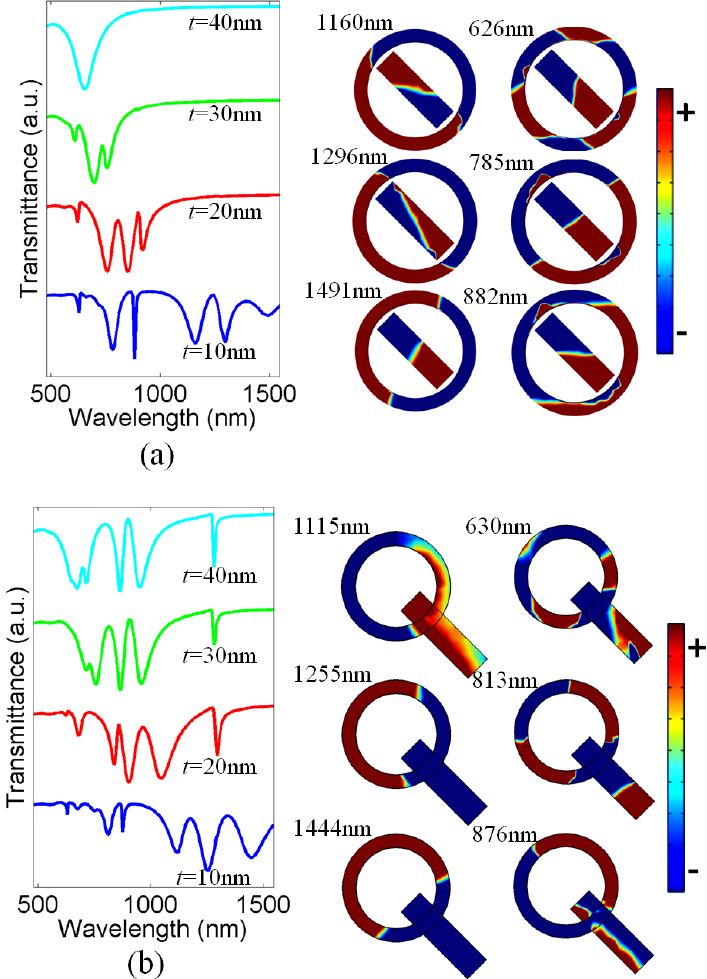
Figure 5. ( a ) Transmission spectra of theta-shaped metasurface. Inset shows surface charge distributions calculated at t = 10 nm; ( b ) Transmission spectra of Q-shaped metasurface for different values of t . Inset shows surface charge distributions calculated at t = 40 nm. Table 3. Q -factor and FoM values around Fano